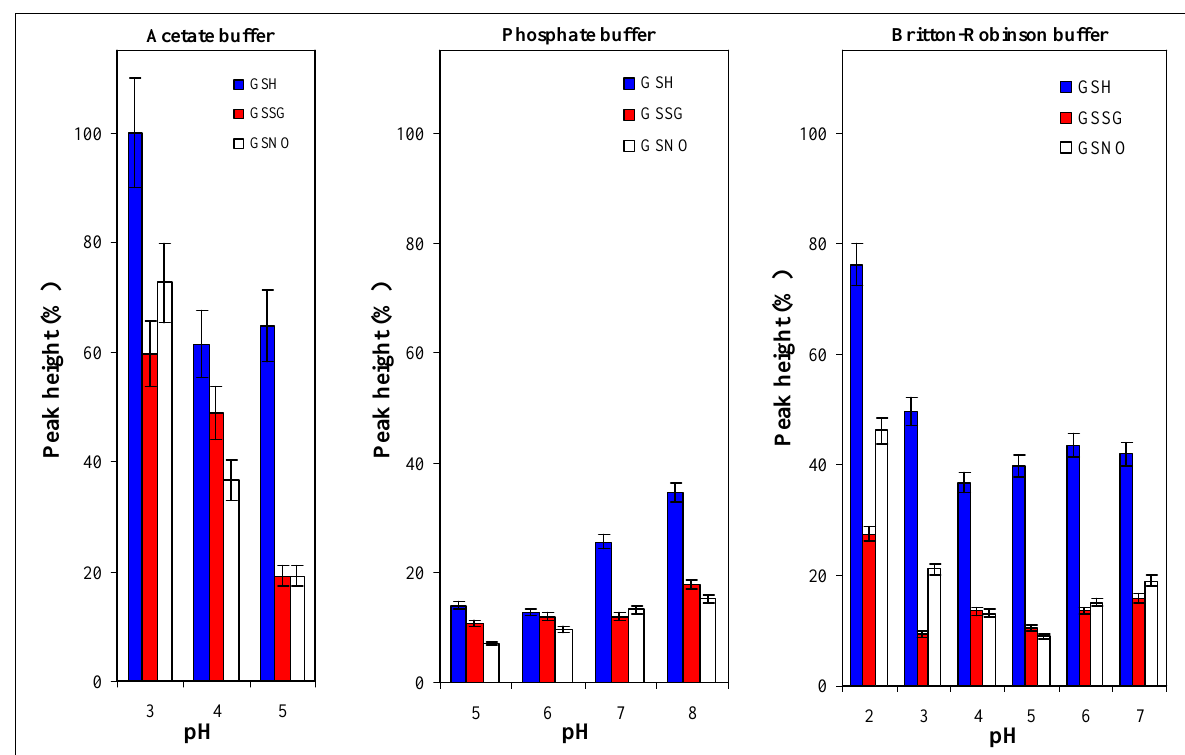
Figure 2. Influence of pH of acetate, phosphate and Britton-Robinson buffers on electrochemical responses of GSH, GSSG and GSNO. Concentration of the buffers: 0.2 M. Flow rate of electrolyte was 1.0 ml.min -1 , potential 700 mV. Signal of GSH measured in the presence of acetate buffer (pH 3.0) of height 468 µA corresponds to 100 %. The concentration of thiols was 30 µg mL -1